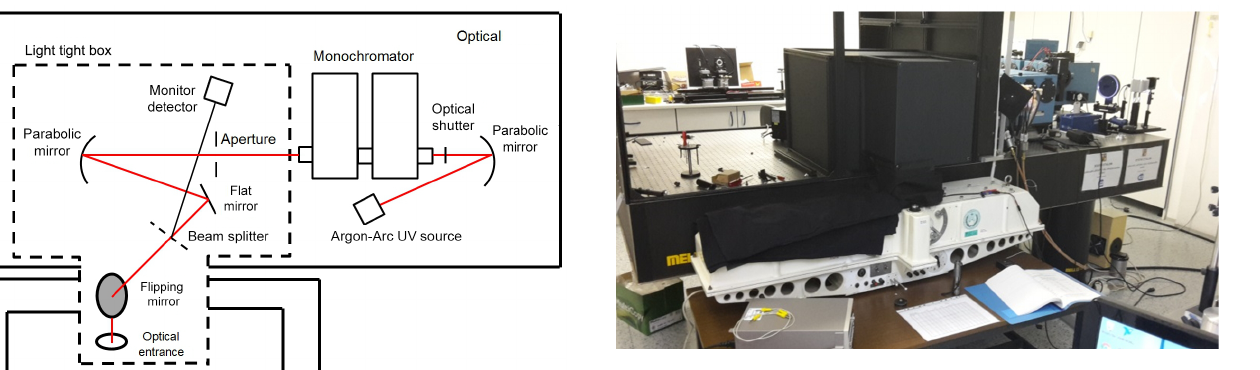
Figure 3. Photo of the CMI measurement setup. Double-grating monochromator is on the left side, the output optics light-tight box in the middle of the picture as well as the Dobson